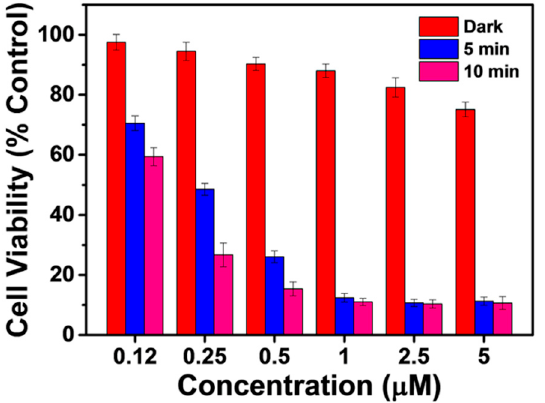
Figure 8. The cell viability of 4T1 cells incubated with QICY at different concentrations and irradiated by 630 nm laser (Laser power density: 20 mW/cm 2 ; Irradiation time: 5 or 10 min).